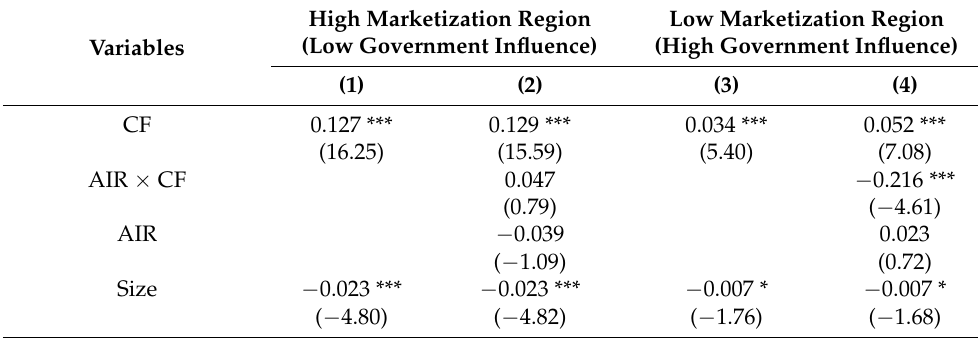
Table 6. Grouping based on government influence-